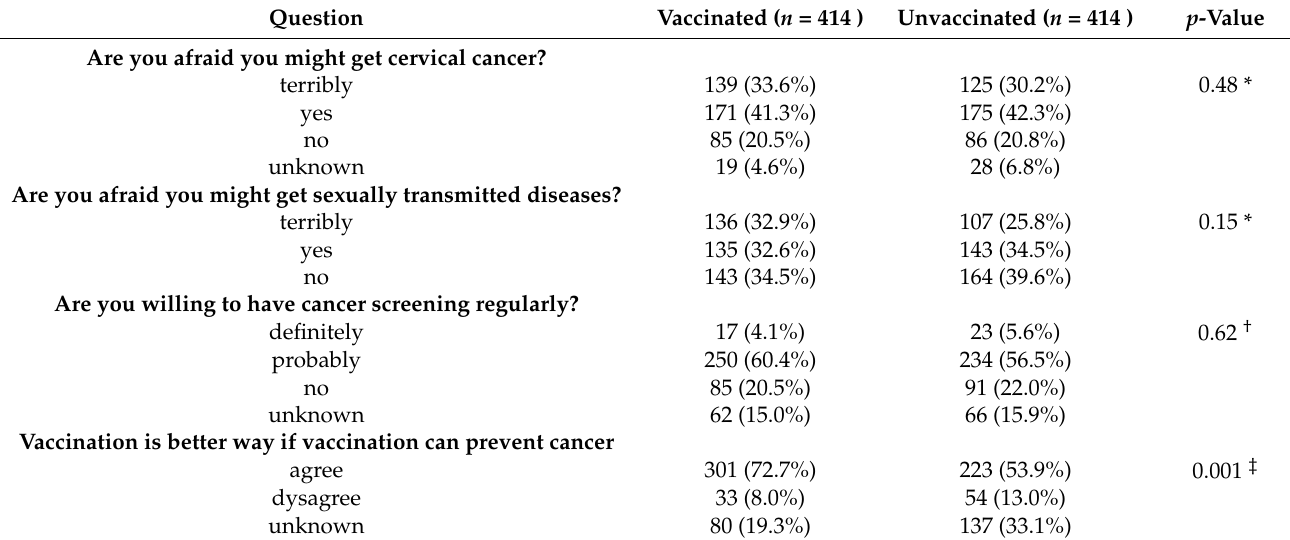
Table 4. Anxiety and preventive action against cervical